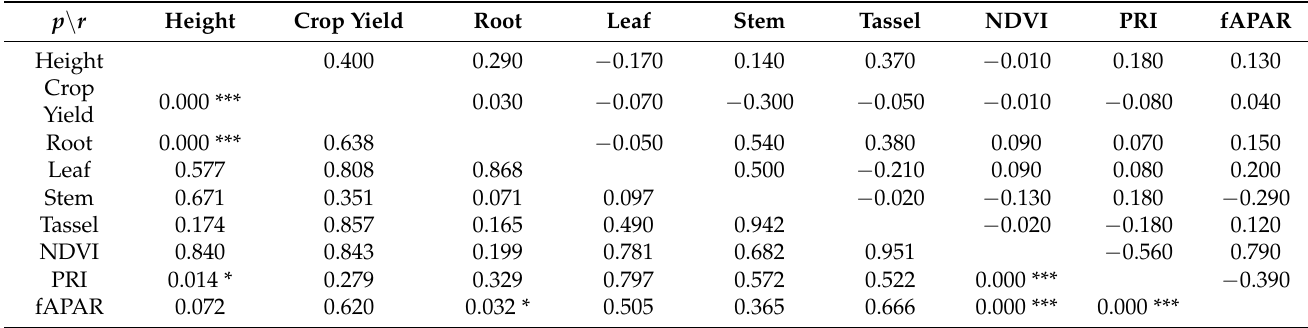
Table 1. Pearson correlation analysis ( r ) and p -value ( p ) between the investigated plant parameters. Correlation is significant at the * 0.05 and *** 0.001 level.